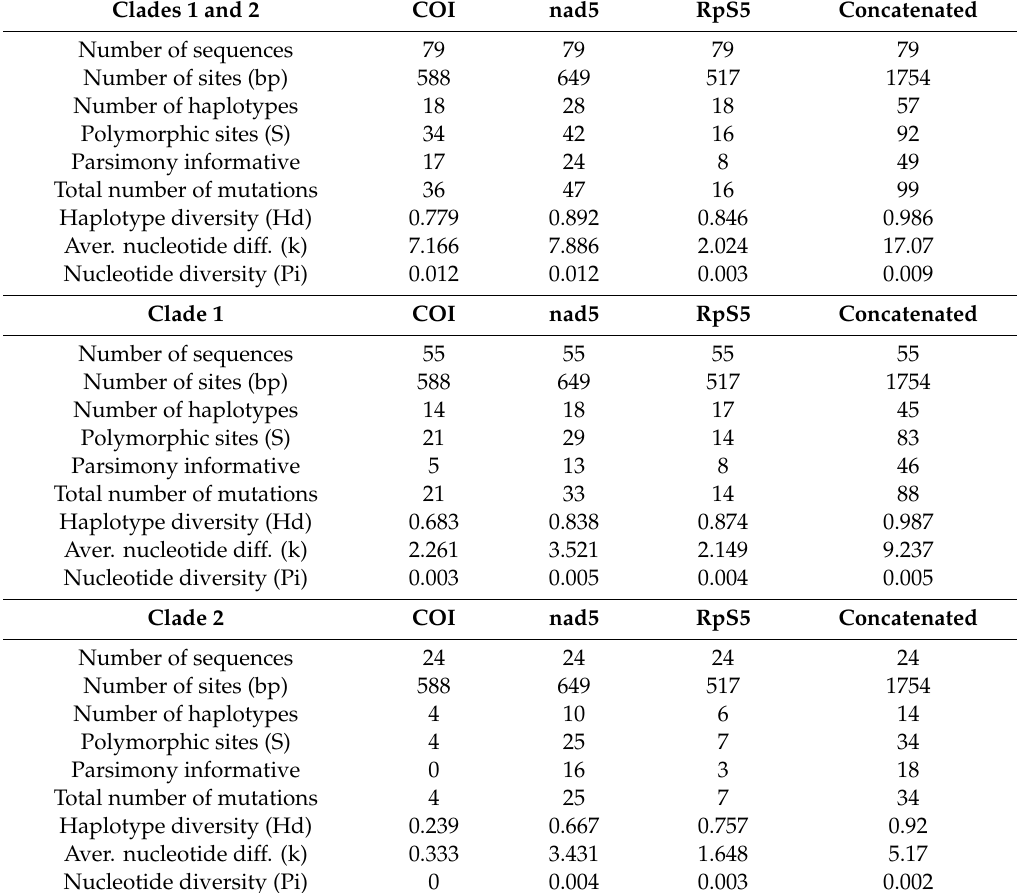
Table 1. Variability of the COI, nad5 and RpS5 amplicons analyzed, considering Tunisian Prays oleae dataset and partitioned by clade1 and clade 2.